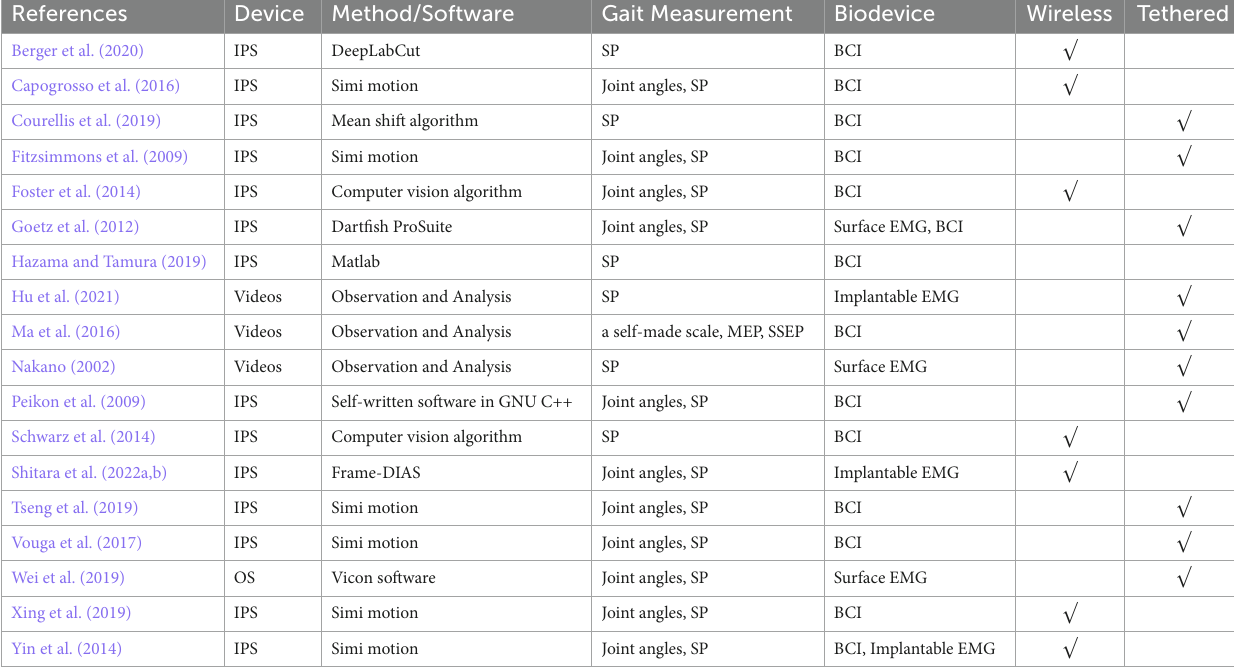
TABLE 4 NHP neuroscience